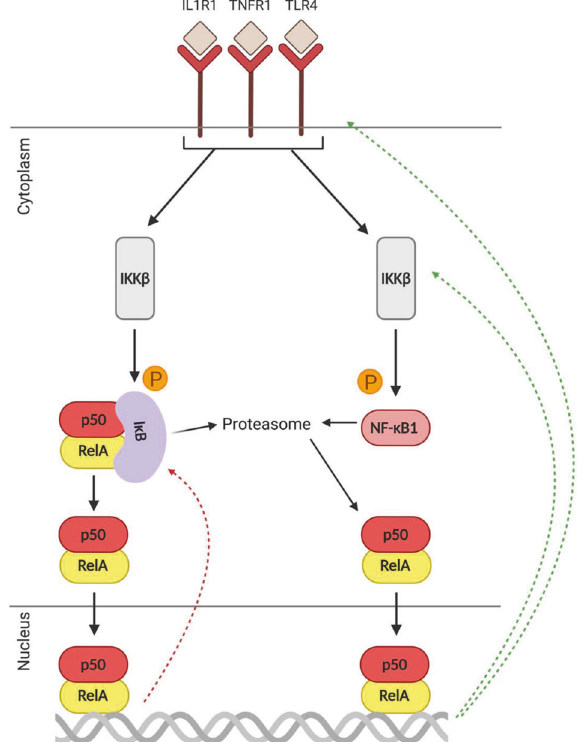
Fig. 3 Regulation of canonical NF- κ B activation. Cell-surface immunoreceptors activate IKK β , which tags I κ B for proteasomal degradation thereby freeing the p50-RelA/cRel dimer. Activation of canonical NF- κ B receptors also enhances the partial processing of NF- κ B1 into p50. As a result of NF- κ B1 processing or I κ B α degradation, the p50-RelA/cRel dimer moves into the nucleus where it initiates pro-in fl ammatory gene transcription. As such, IKK β and I κ B are considered the central regulators of the canonical pathway. Red dotted arrows indicate negative feedback via I κ B transcription, green dotted arrows indicate positive feedback via receptor and IKK β